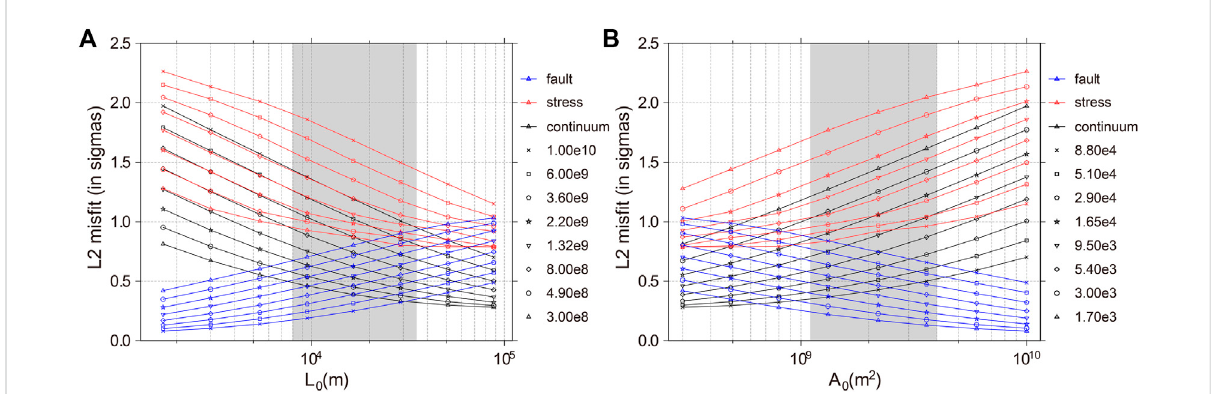
FIGURE 9 TheL2-normmis fi terrorsofcontinuumstrain-rate,stressdirection,andfaultsliprateunderthereferencemodelwithdifferentcombinationsof A L fi t errors; (B) Reference length L fi t errors; Continuum strain-rate, L 0 and 0 . (A) Reference length 0 versus the L2-norm mis 0 versus the L2-norm mis stress direction, and fault slip rate errors are represented by symbols and connected lines in black, red, and blue, respectively. Different symbols represent mis fi t errors versus L 0 at different A 0 (in m 2 ). Gray shadow shows the preferred range of L 0 and A 0